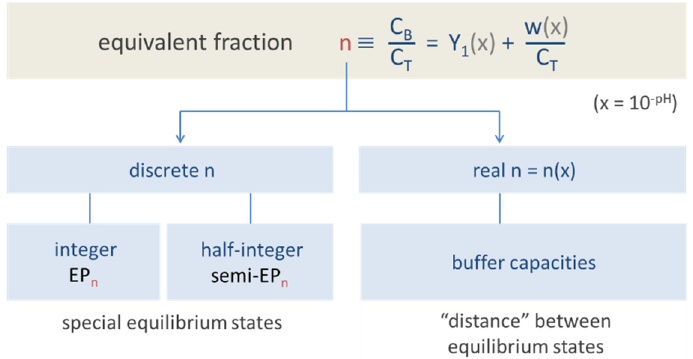
Figure 1. Equivalent fraction as the central quantity from which all other formulas follow.